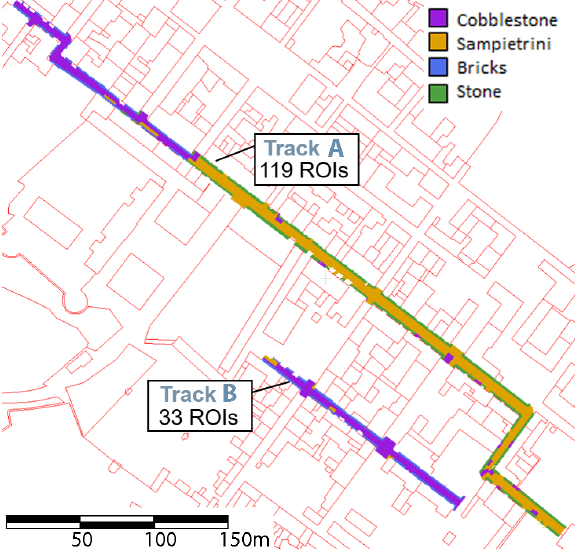
Figure 8. The two tracks of the case-study selected, after the paving material characterisation computation. In purple the ”cobbelstone” class, in orange the ”sampietrini” class, in blue the ”bricks” class, and in green the ”stone”